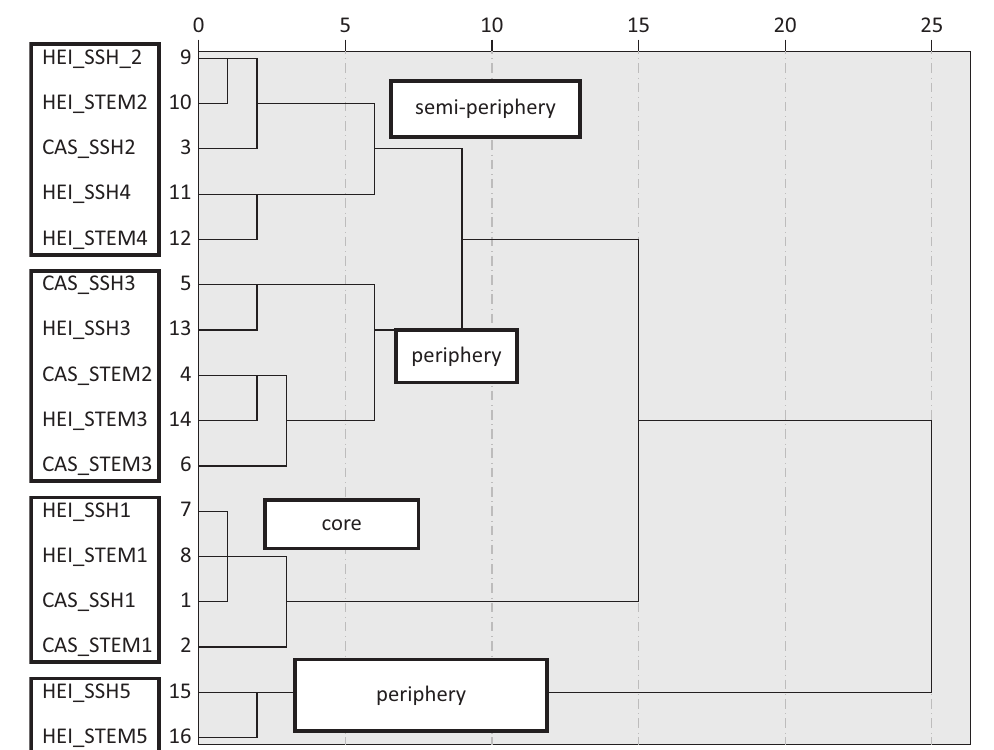
Figure 1. Dendrogram (ALM segments). Data from the “Academics 2017”